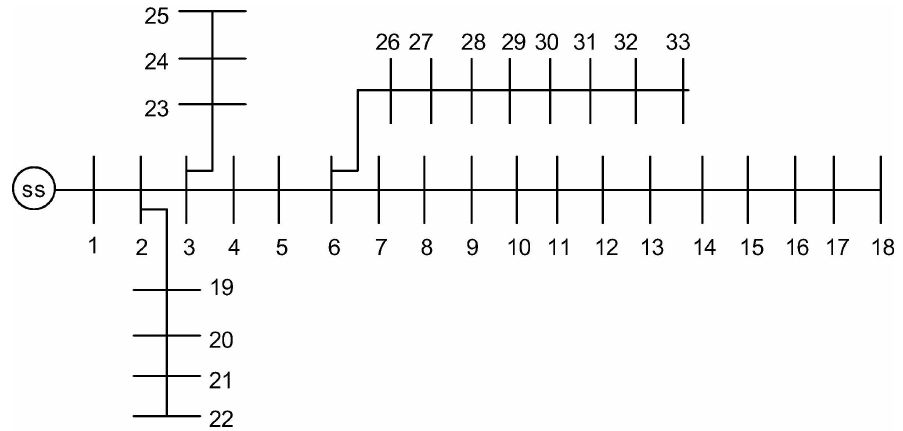
Figure 1. IEEE 33-node test system—NW-1. Voltage profile for DG-Type 1 has been compared between SPPA, MBA, and without DG. In this study, the external grid is connected to node 1, which is considered as the reference, and the voltage at node 1 is taken as 1 pu. After the optimal placement of DG with the SPPA technique, a significant improvement in the voltage profile is observed. After the optimal placement, the minimum voltage of 0.9929 pu occurs at Bus 18. These results are shown in Figure 2.